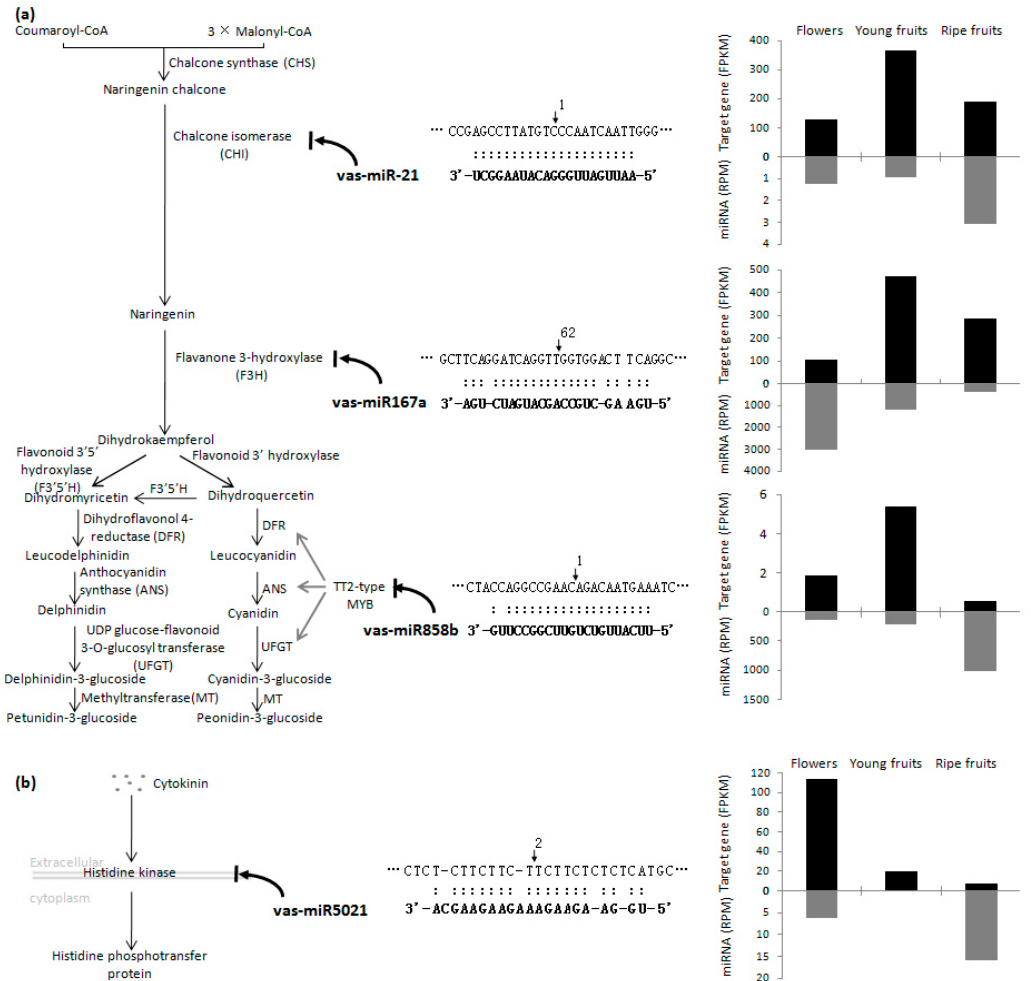
Figure 2. Blueberry miRNA–target gene regulatory networks involved in anthocyanin biosynthesis ( a ) and cytokinin signal transduction ( b ). The right of each miRNA showed the corresponding miRNA:target alignment and the expression levels of miRNA and its target gene in flowers, young fruits, and ripe fruits. The arrow on the target transcript indicates the cleavage site and the number above the alignment indicates the number of RNA degradation tags with the 5 ′ -end overlapped to the cleavage site.